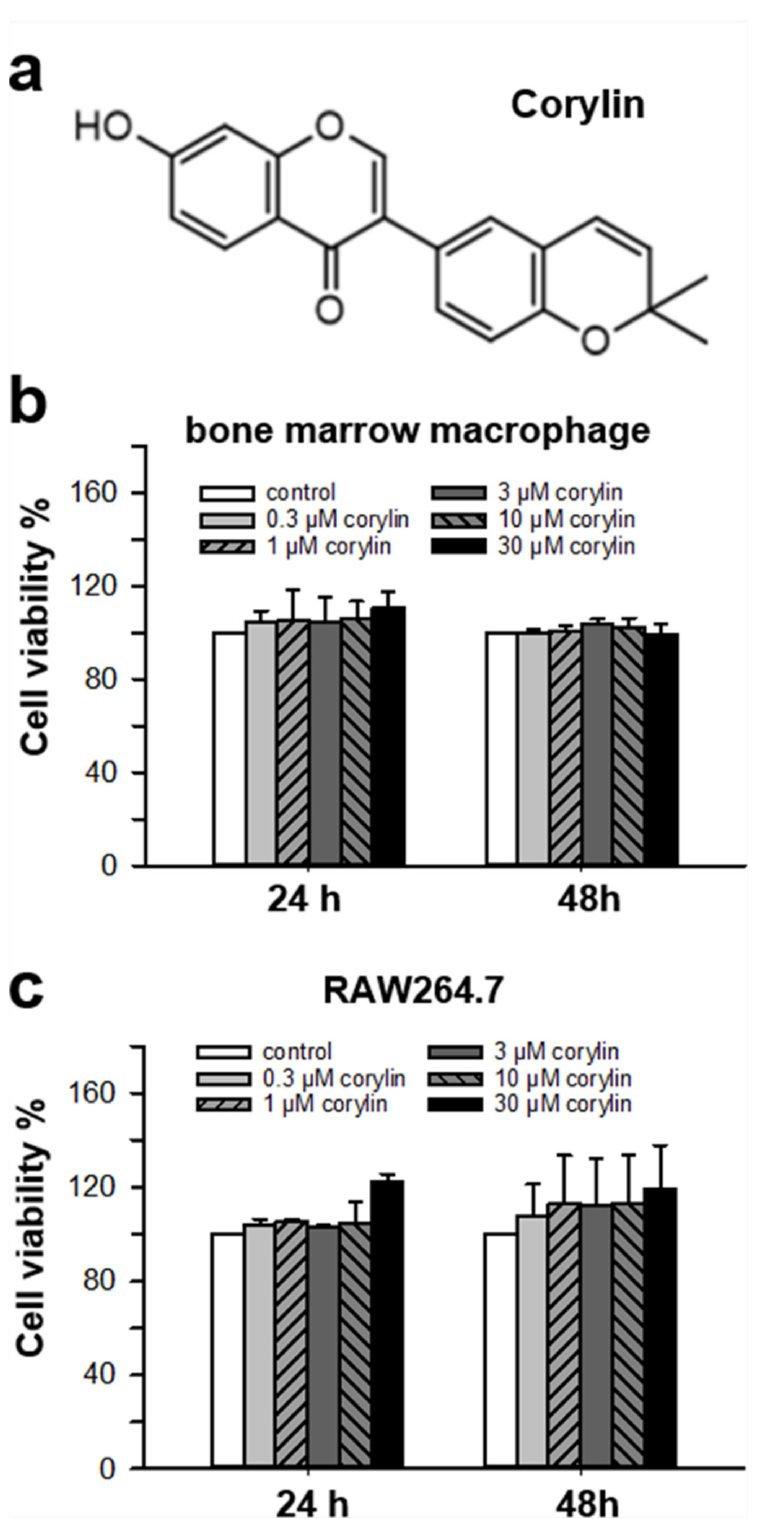
Figure 1. ( a ) Chemical structure of corylin. Cell viability of ( b ) cultured bone marrow macrophages or ( c ) RAW 264.7 cells treated with corylin for 24 h and 48 h, respectively. Data represent the mean ± SD, n = 4, each with triplicate samples. p < 0.05, compared with